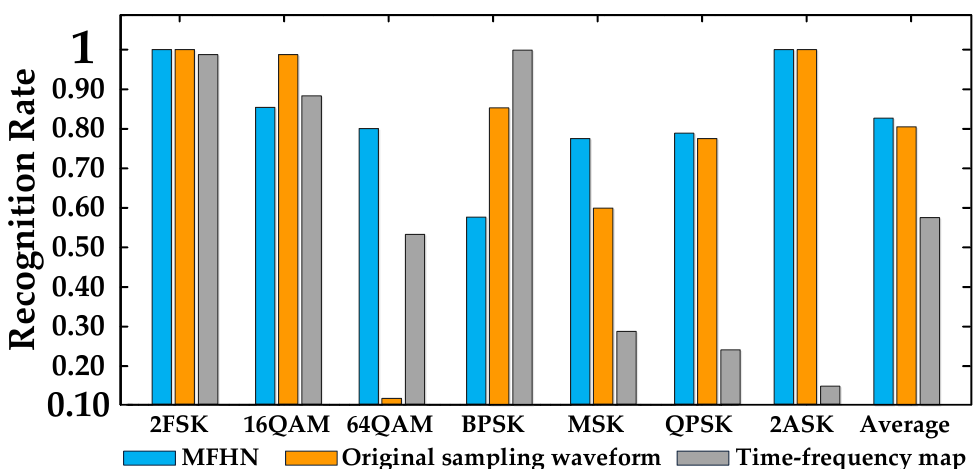
Figure 12. Experimental results on signal dataset 2 in which the signal parameters to be recognized are inconsistent with those of the training set. ( a ) Original sampling waveform. ( b ) Time-frequency map.